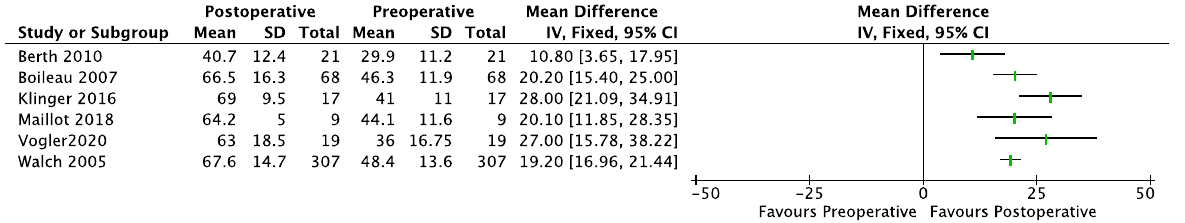
Figure 4. Forest plot of comparison: VAS, outcome in PCR ‐ BT. SD: Standard Deviation. Figure 5. Funnel plot of comparison: VAS, outcome in PCR ‐ BT. SE: Standard Error; MD: Mean Dif ‐ ference. For BT, the results from 5 studies (cases series = 2, case–control = 2, prospective cohort study = 1) [16,22,35,37,38] involving 437 shoulders demonstrated significant improve ‐ ments at the final follow ‐ up (range, 4, 6.1) (Figures 6 and 7).